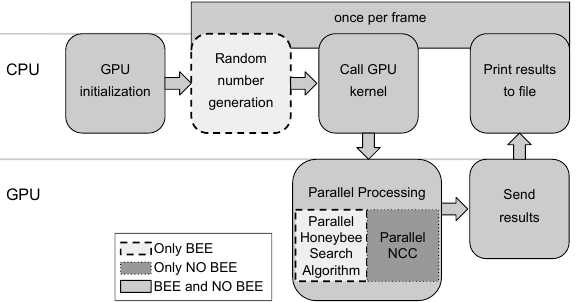
Figure 3. Workflow of programs BEE and NO BEE. The random number generation is only used in program BEE. Parallel NCC is specific to program NO BEE and Parallel HSA is specific to program